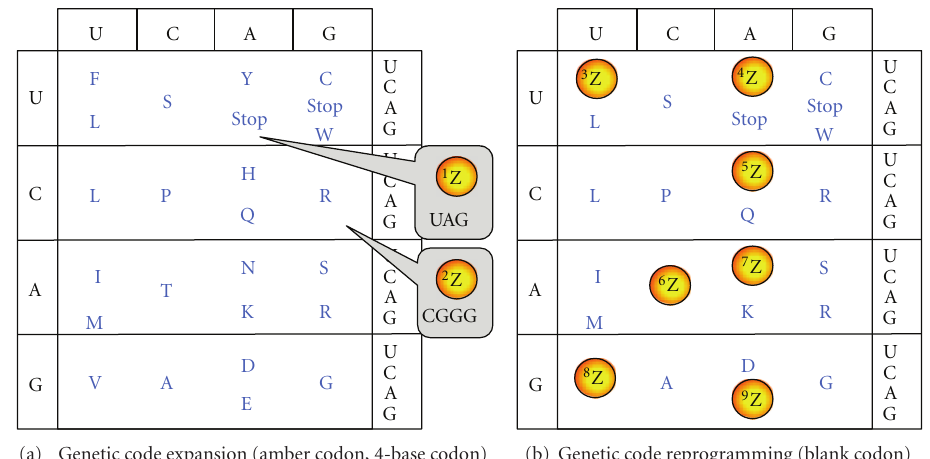
Figure 1: Generation of genetically encoded libraries of nonstandard peptides. (a) Genetic code expansion. Nonproteinogenic amino acids are assigned to the amber codon and four-base codons. (b) Reprogramming the genetic code. Nonproteinogenic amino acids are reassigned to blank codons generated by reconstructing a cell-free translation system with a reduced number of amino acids and protein factors. n Z ( n = 1–9) represents one of the nonproteinogenic amino